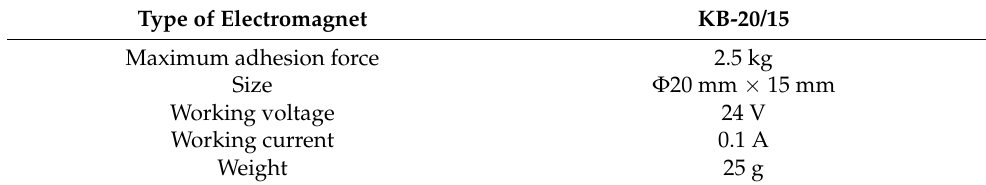
Figure 14. Prototype design of the origami crawling robot: ( a ) side view of the crawling robot with rubber sliding feet; ( b ) rubber sliding feet; ( c ) side view of the crawling robot with electromagnetic sliding feet; ( d ) electromagnetic sliding feet. Table 2. Parameters of the KB-20/15